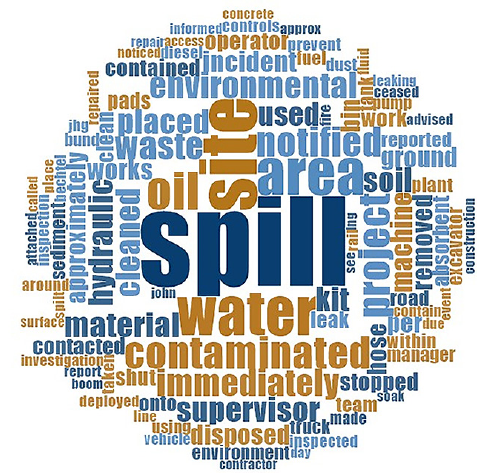
Figure 5. Word cloud analysis for immediate actions